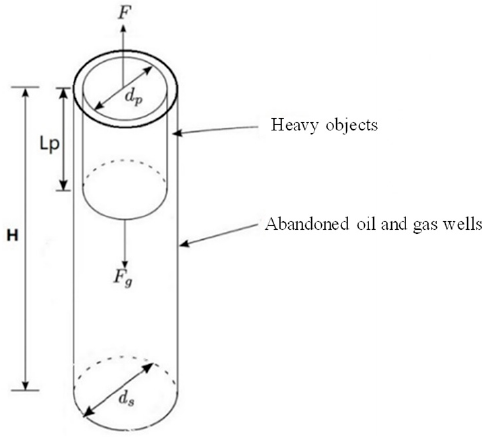
Figure 2. A model of the gravity energy storage system.